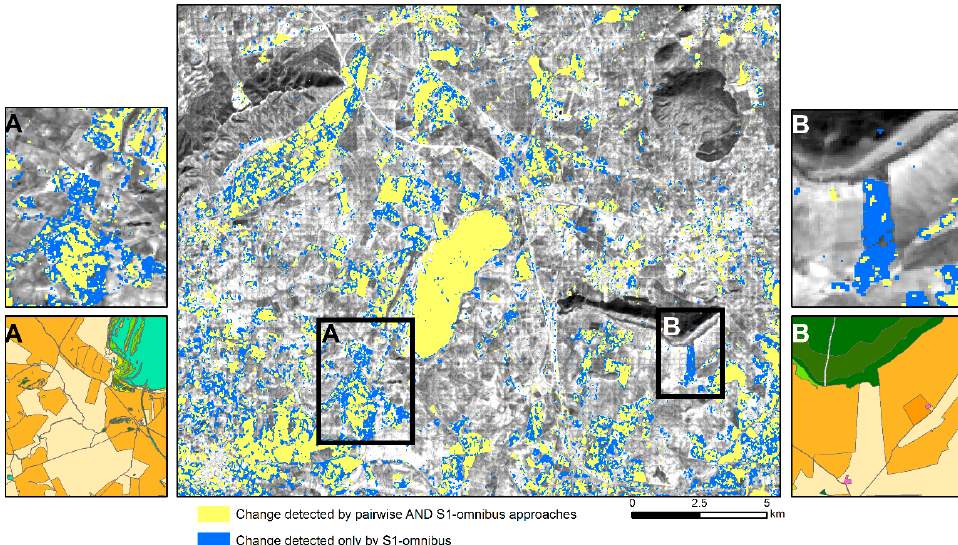
Figure 5. Changes detected in Fuente de Piedra by the pairwise change detection approach (yellow) overlaid on top of the S1-omnibus change detection results (blue). Changes in water level and in most crops are well detected by both approaches. Subset A shows how the S1-omnibus is capable of detecting changes in patches of crops matching the LULC map better (in the LULC map, orange is olive groves and beige herbaceous crops); Subset B shows how S1-omnibus can even detect whole patches of change that are missed with the pairwise approach (Landsat 8 band 4 used as the background image).